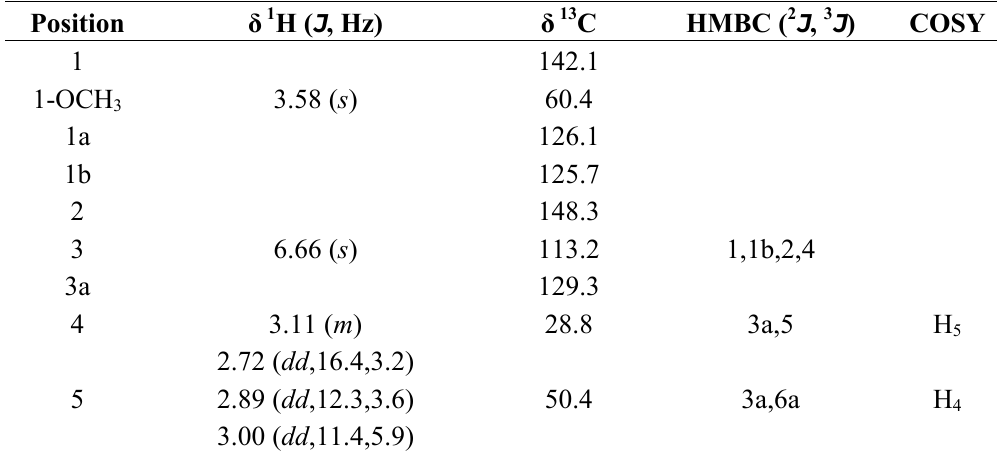
CDCl ( δ in ppm, J in 3